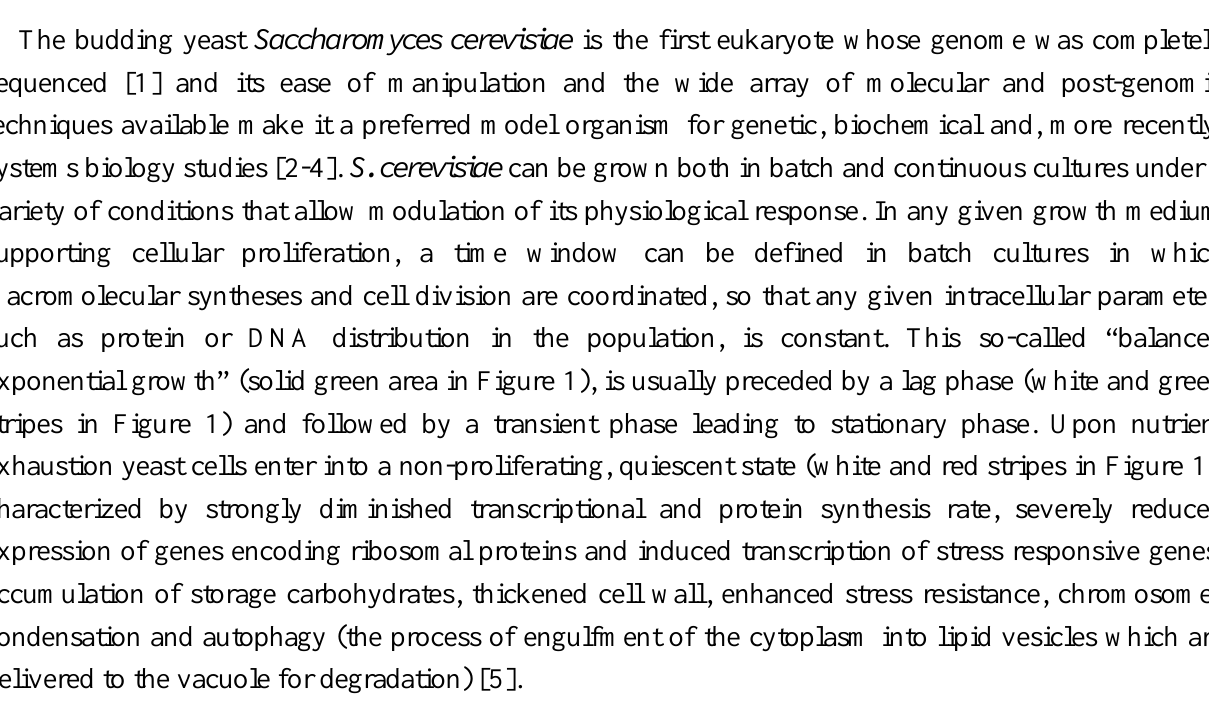
Figure 1. Growth phases of S. cerevisiae cultivated in rich medium supplemented with glucose. When quiescent, stationary phase cells are inoculated in fresh medium, they exhibit an initial lag phase of variable length. During the subsequent exponential phase cells proliferate rapidly by fermenting glucose to ethanol. When glucose becomes limiting, cells transiently arrest growth to adjust their metabolism from fermentative to the respiratory mode (diauxic shift): after the switch to respiration, cells restart growing at a reduced rate by slowly consuming the ethanol accumulated in the medium. When ethanol is also exhausted, cells cease dividing and enter into a quiescent state known as stationary phase that becomes deeper and deeper as cells spend more time in this state. Solid colors indicate steady states, diagonal stripes transient